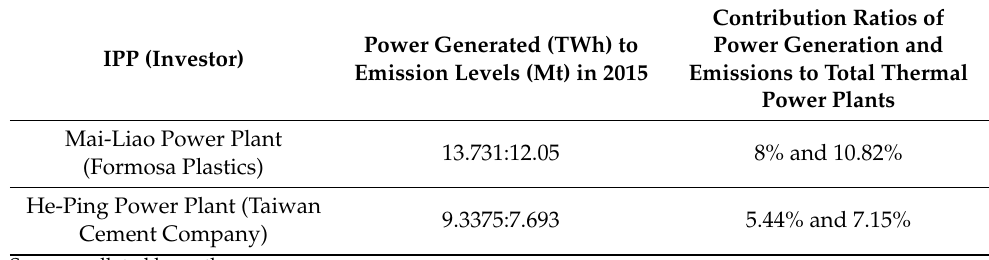
Table 2. The power generation and GHG emission contributions from Taiwan’s IPP